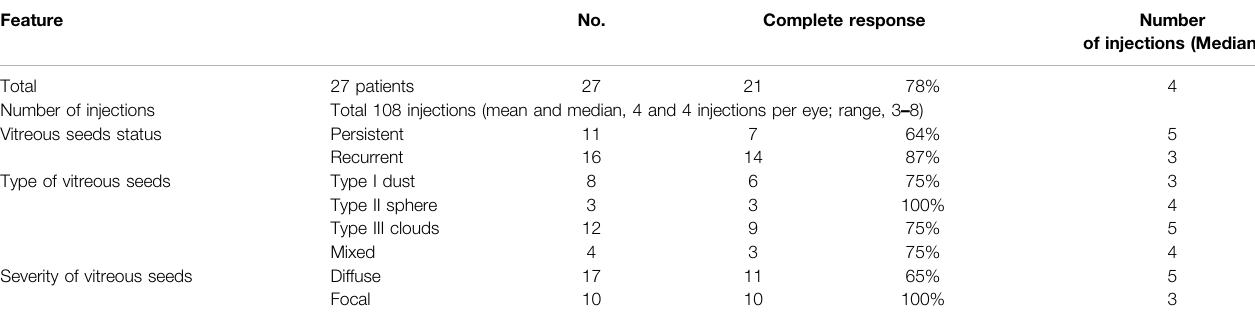
TABLE 2 | Correlation between tumor characteristics and the number of injections. Feature No.